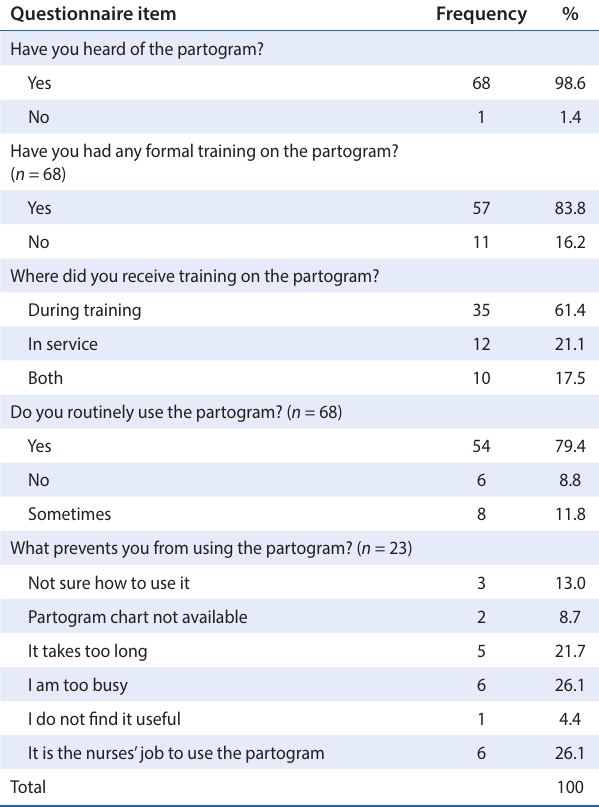
Table 3: Knowledge of the partogram Questionnaire items (1–7): General knowledge of the